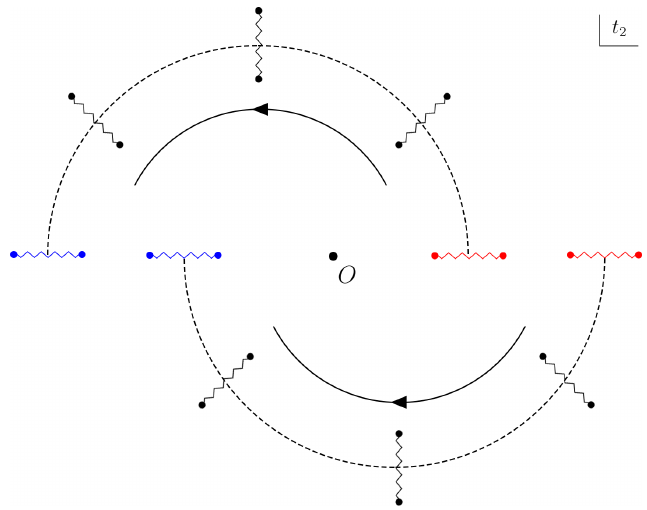
Figure 6 . The deformations of branch cuts on the spectral curve ( t 2 -plane) from O to O 0 on the U -plane for SU(2) 0